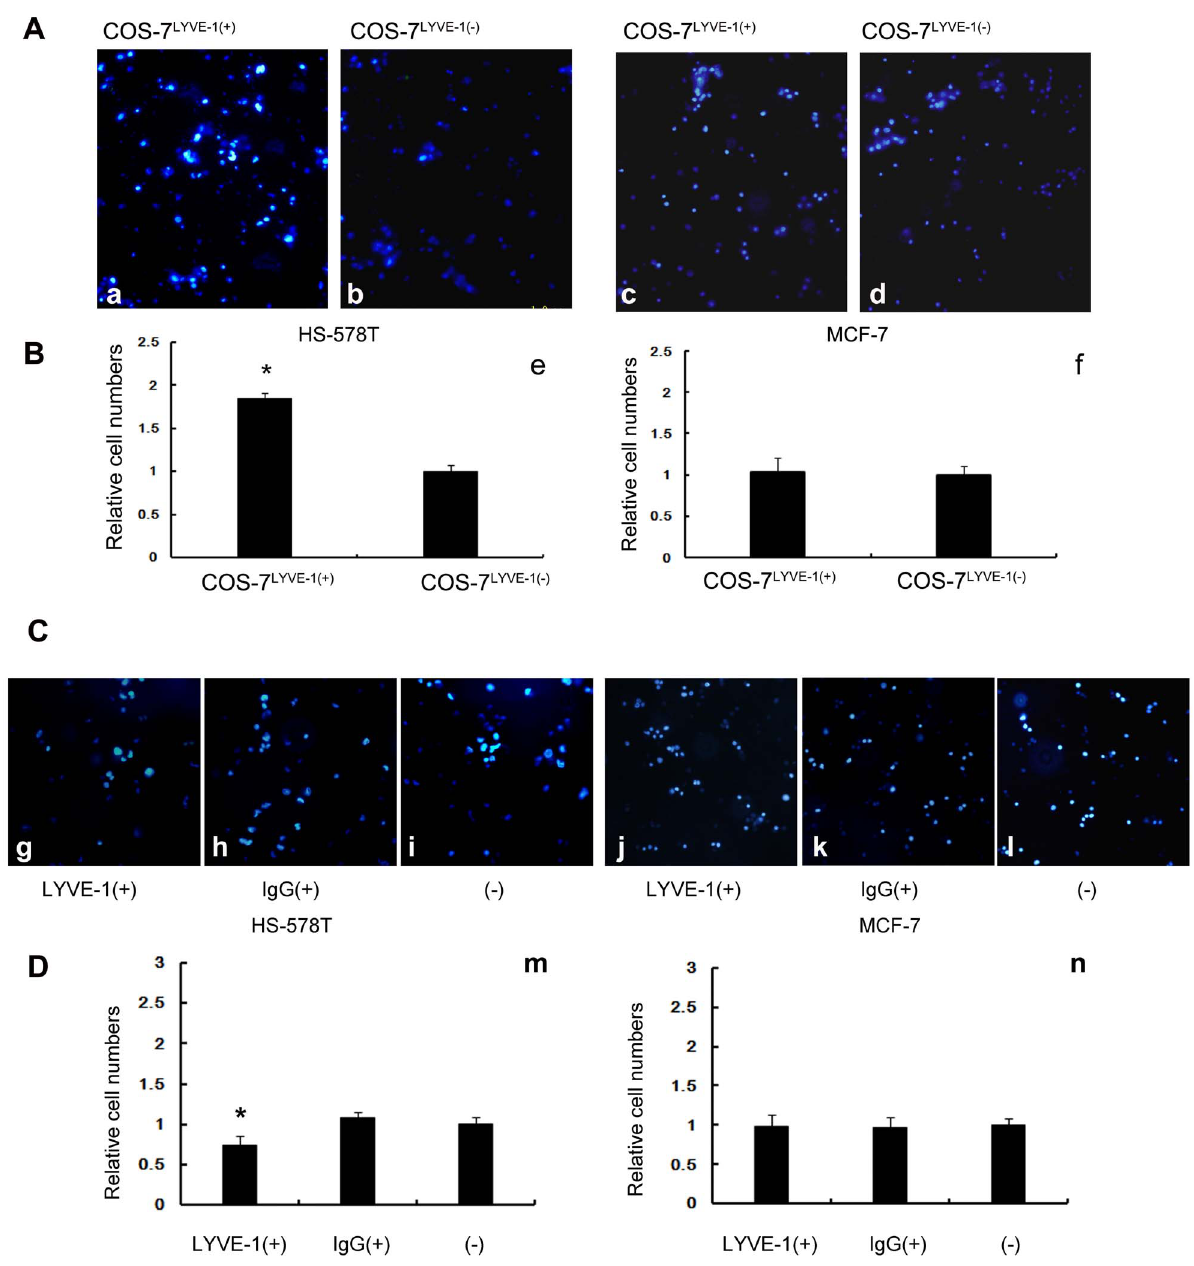
Figure 3. Breast tumor cells expressing high or low levels of HA adhere differently to cells during low flow conditions. (A) The number of HS-578T and MCF-7 cells adhered to COS-7 LYVE-1( + ) and COS-7 LYVE-1( 2 ) cells under 0.1 dyn/cm 2 low shear stress was evaluated by counting 5 random views of fluorescence microscope images. Adhered HS-578T and MCF-7 cells appear as blue spheres (a–d). (B) Quantitative evaluations of the data representing HS-578T and MCF-7 cell adhesion on the monolayer of COS-7 cells are shown, and each assay was performed in triplicate. The results are shown as the mean 6 SD of triplicate wells from a typical experiment and are expressed as a fold increase relative to control pEGFP-N1 vector transfected COS-7 cells. *P , 0.05 versus the indicated transfected pEGFP-N1 vector control COS-7 cells. (C) The number of HS-578T and MCF-7 cells adhered to SVEC4-10 cells before and after blocking with LYVE-1 antibody, isotype antibody under 0.1 dyn/cm 2 low shear stress was evaluated by counting 5 random views of fluorescence microscope images (g–l). (D) Quantitative evaluations of the data from HS-578T and MCF-7 cell adhesion on the monolayer of SVEC4-10 cells are shown. Each assay was performed in triplicate. The results are shown as the mean 6 SD of triplicate wells from a typical experiment and are expressed as a fold decrease relative to SVEC4-10 cells without treatment. *P , 0.05 versus SVEC4-10 cells without treatment. doi:10.1371/journal.pone.0063463.g003 cells to lymph endothelial cells, we used SVEC4-10 cells to repeat experiment with MCF-7 cells and COS-7 LYVE-1( + ) and COS- the adhesion. Only a slightly decrease was observed after using the 7 LYVE-1( 2 ) cells. The present study showed that LYVE-1 did not enhance the adhesion of MCF-7 cells lacking HA on their surface blocking antibody, which may be caused by limited interactions to COS-7 cells. Furthermore, to best model the adhesion of tumor with HA and LYVE-1 on SVEC4-10 cells. Taken together, these